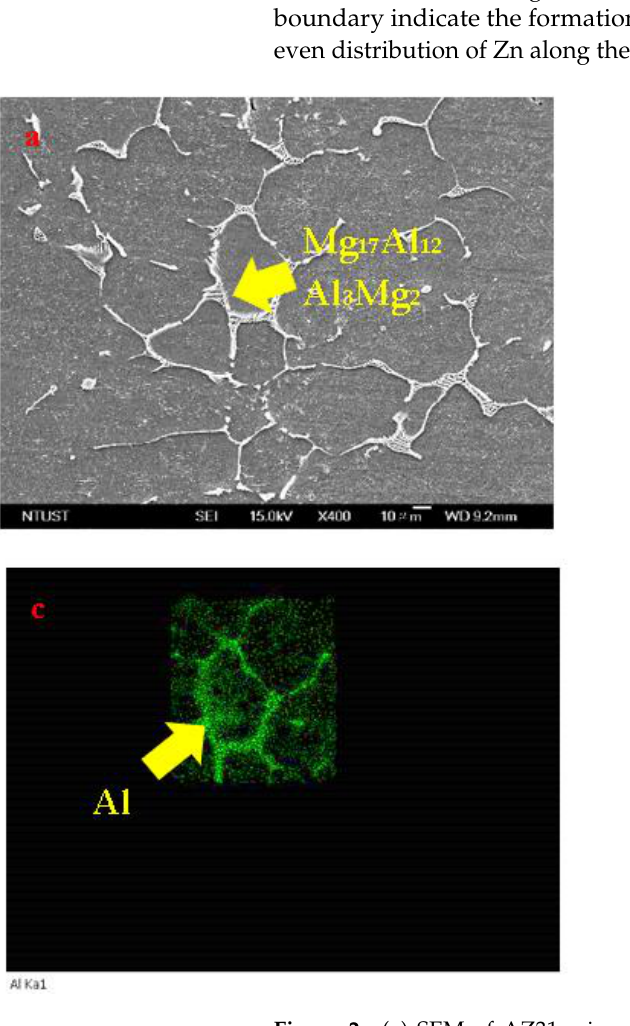
Figure 2. ( a ) SEM of AZ31 microstructure, ( b ) EDS shows Mg distribution, ( c ) EDS shows Al distribution, and ( d ) EDS shows Nb distribution.